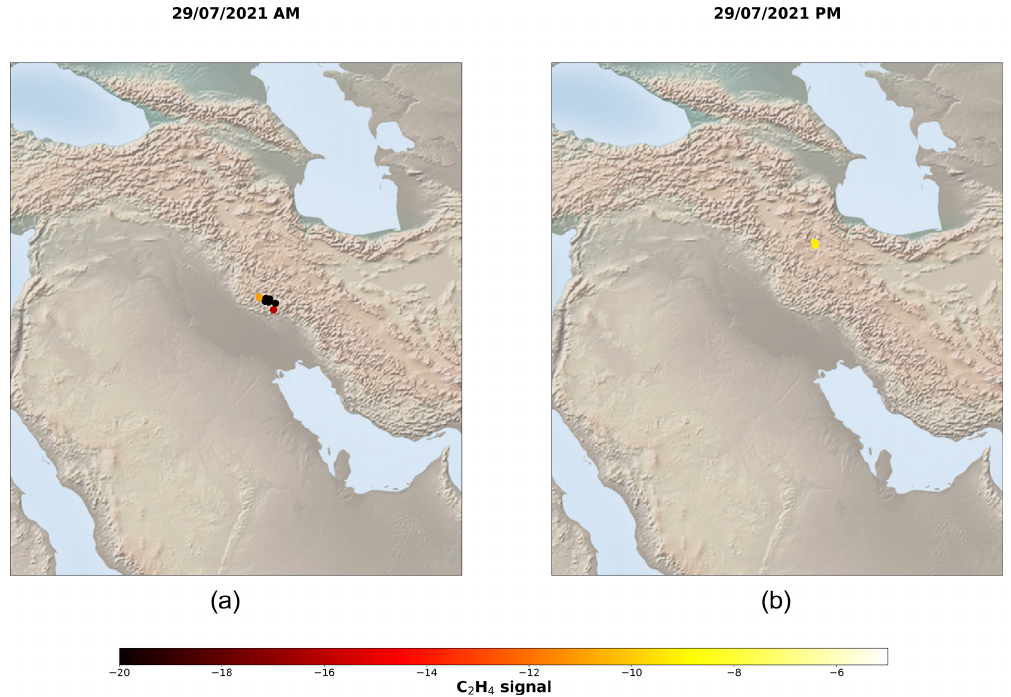
Figure 15. Analysis of the acetylene sporadic emission event in Iraq on 29 July 2021 based on IASI/Metop-A L1C data. (a) Spatial distri- bution of residual values associated with C 2 H 4 during the morning orbit. (b) Spatial distribution of residual values associated with C 2 H 4 during the evening